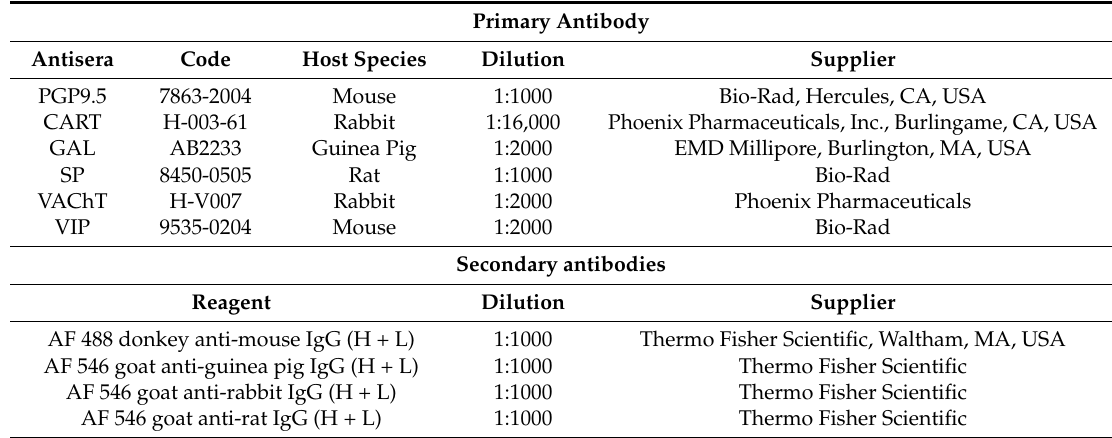
Table 2. Reagents used in immunofluorescence